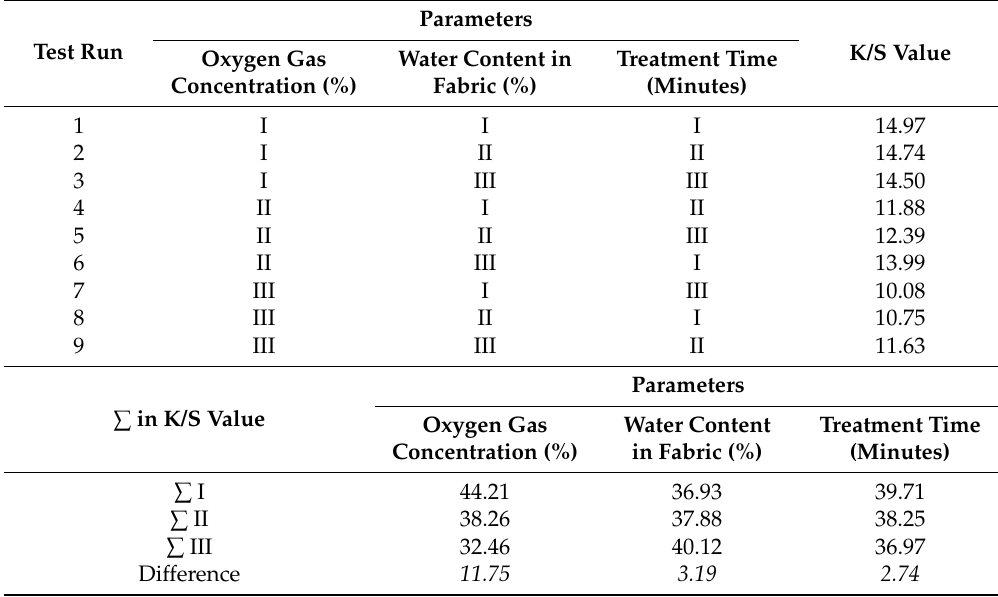
Table 5. Orthogonal table for optimising the plasma-induced ozone colour-fading treatment of sulphur-dyed knitted cotton fabric.